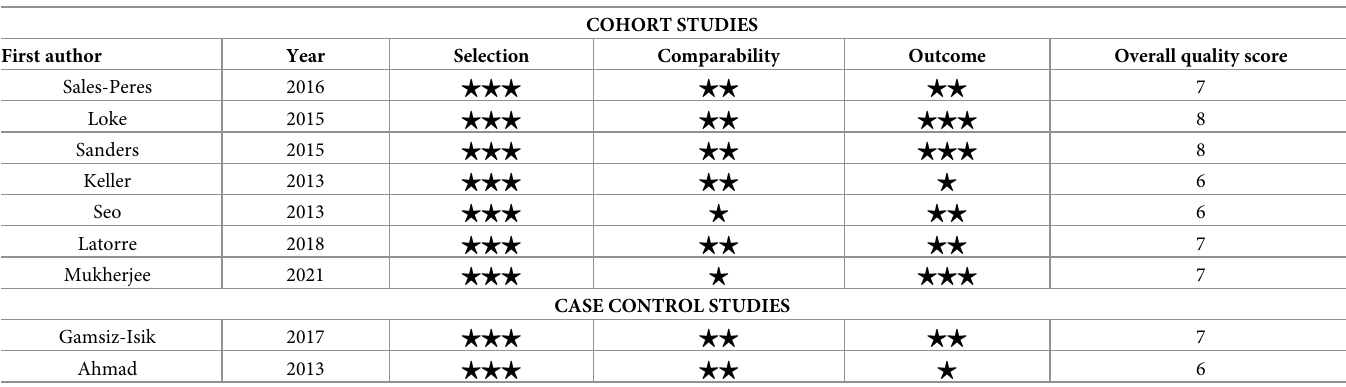
shows the forest plot of periodontitis incidence in OSA risk patients, and Fig 4 shows the results of sensitivity analysis.